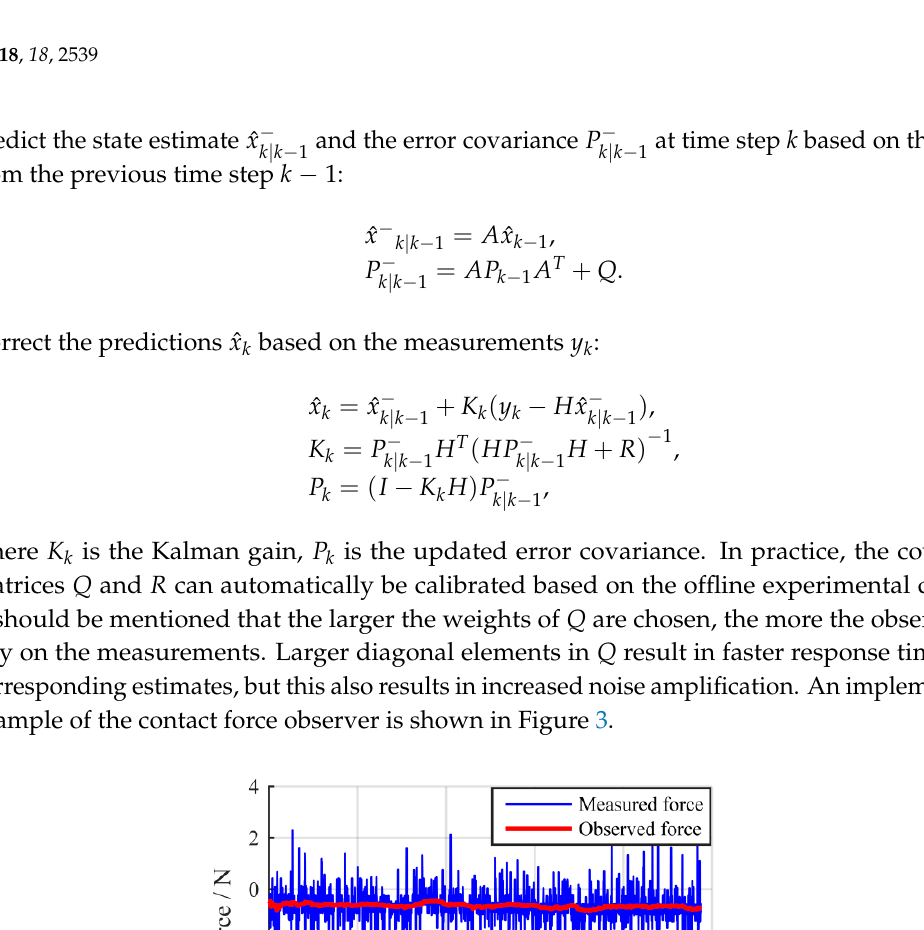
Figure 4. The position-based impedance control schematic.